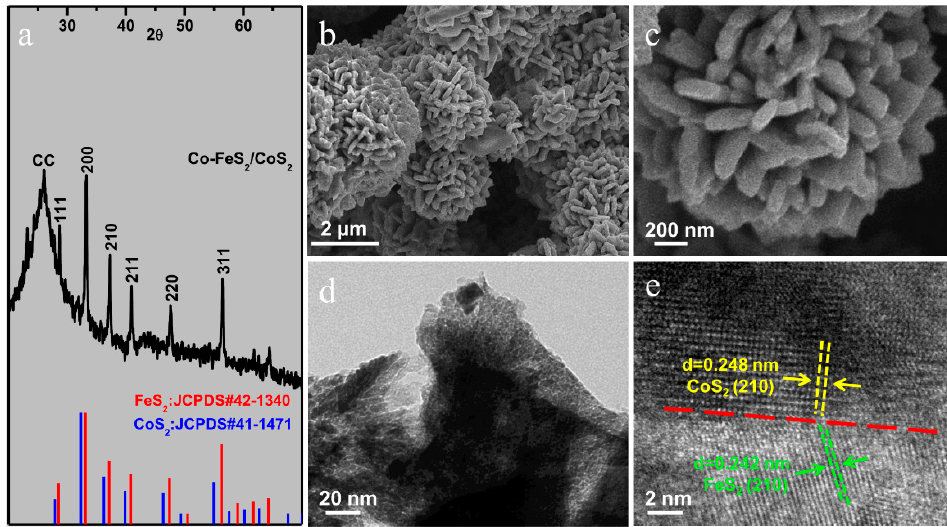
Figure 1. ( a ) The X-ray diffraction (XRD) patterns for Co-FeS 2 /CoS 2 heterostructure; ( b ) and ( c ) SEM images of Co-FeS 2 /CoS 2 heterostructure; ( d ) TEM image of Co-FeS 2 /CoS 2 heterostructure; ( e ) HRTEM image of Co-FeS 2 /CoS 2 heterostructure.